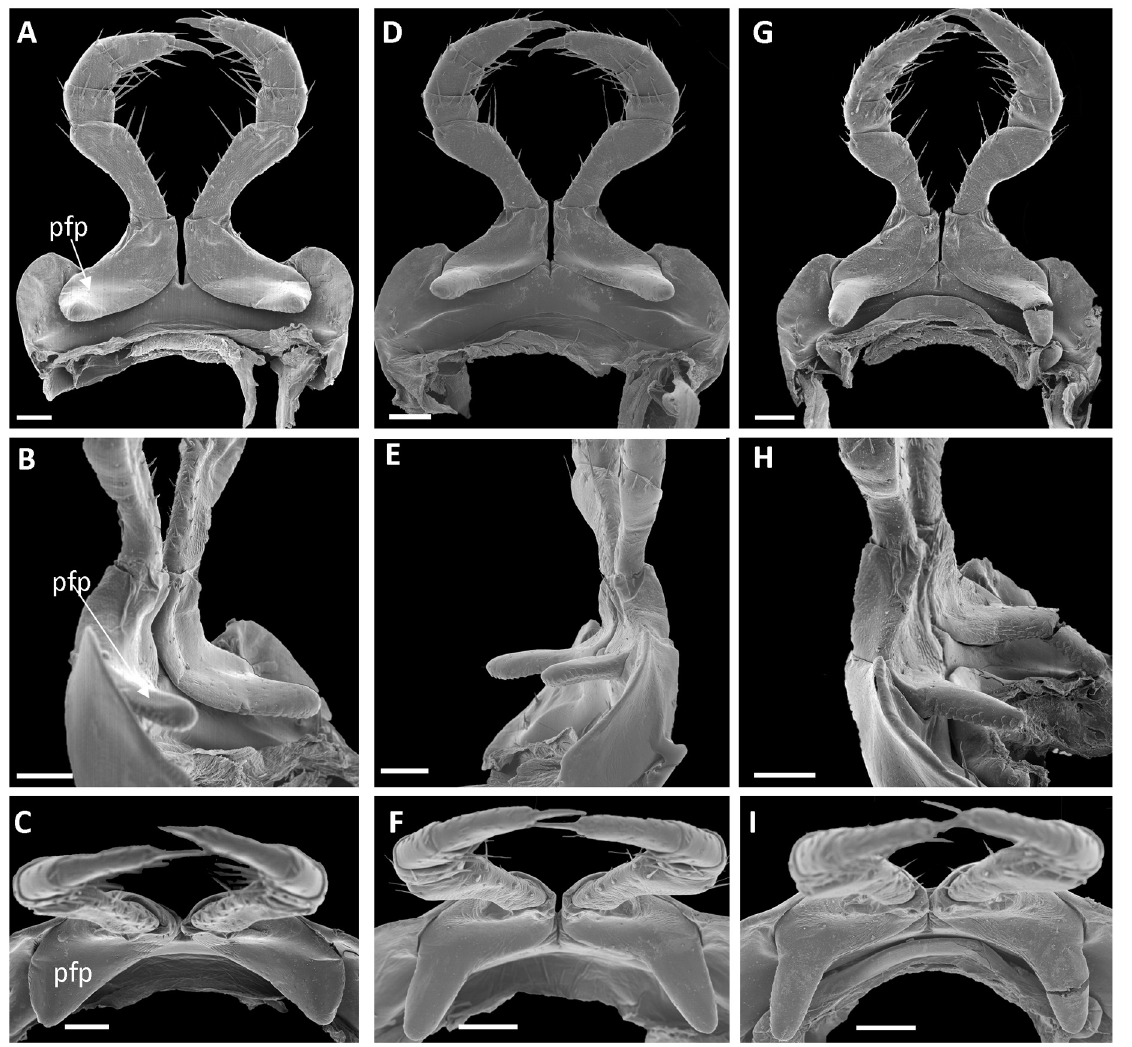
Fig. 3. Aquattuor spp., first pair of male legs. A – C . A. fasciatus (Attems, 1896), non-type male from Zanzibar (NHMD 621641). D – F . A. claudiahempae Enghoff & Frederiksen, 2015, paratype from Kilimanjaro (NHMD 621638). G – I . A. claudiahempae , specimen from Udzungwa Mts (NHMD 621639). A, D, G . Anterior view. B, E, H . Sublateral view. C, F, I . Ventral view. Abbreviation: pfp = prefemoral process. Scale bars = 0.1